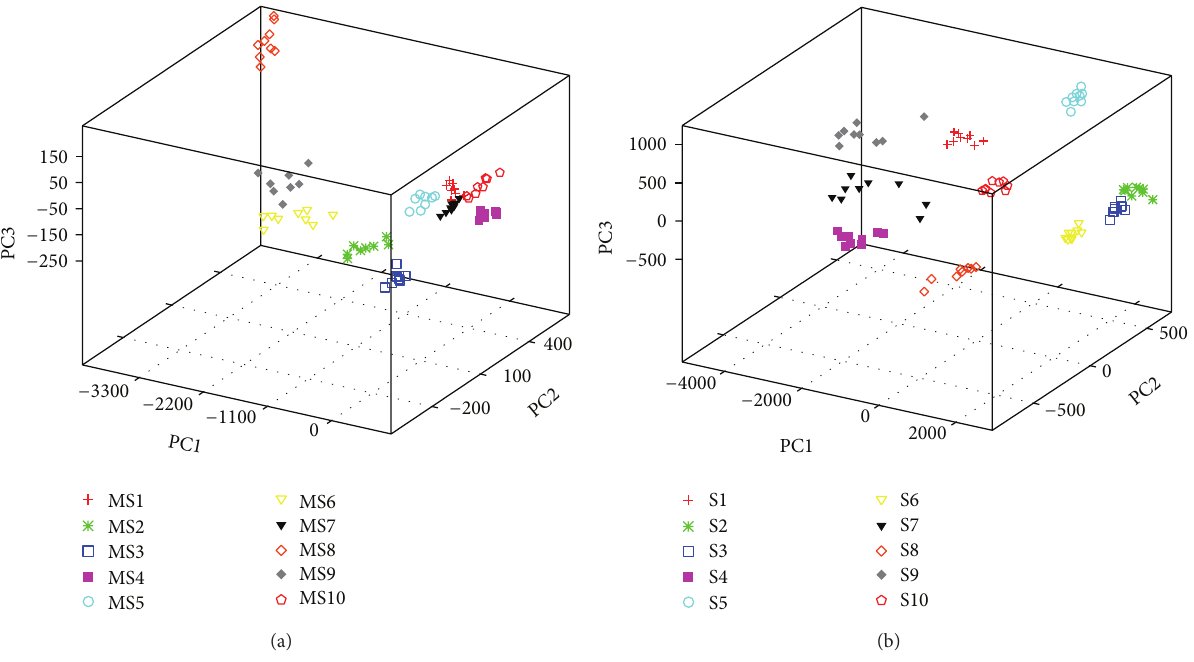
Figure 6: Intrasubject variability represented by first three principal components as shown by PC1, PC2, and PC3 for ten different subjects of (a) MIT-BIH arrhythmia database and (b) IIT (BHU)